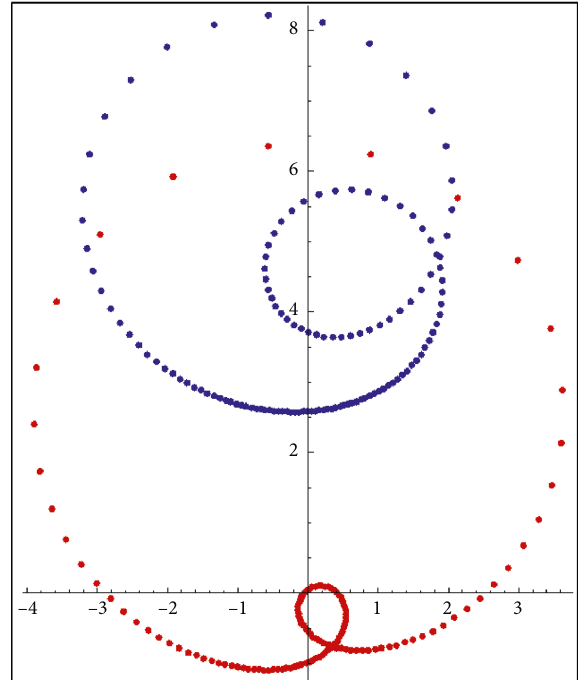
( t ) (top curve) and h 0